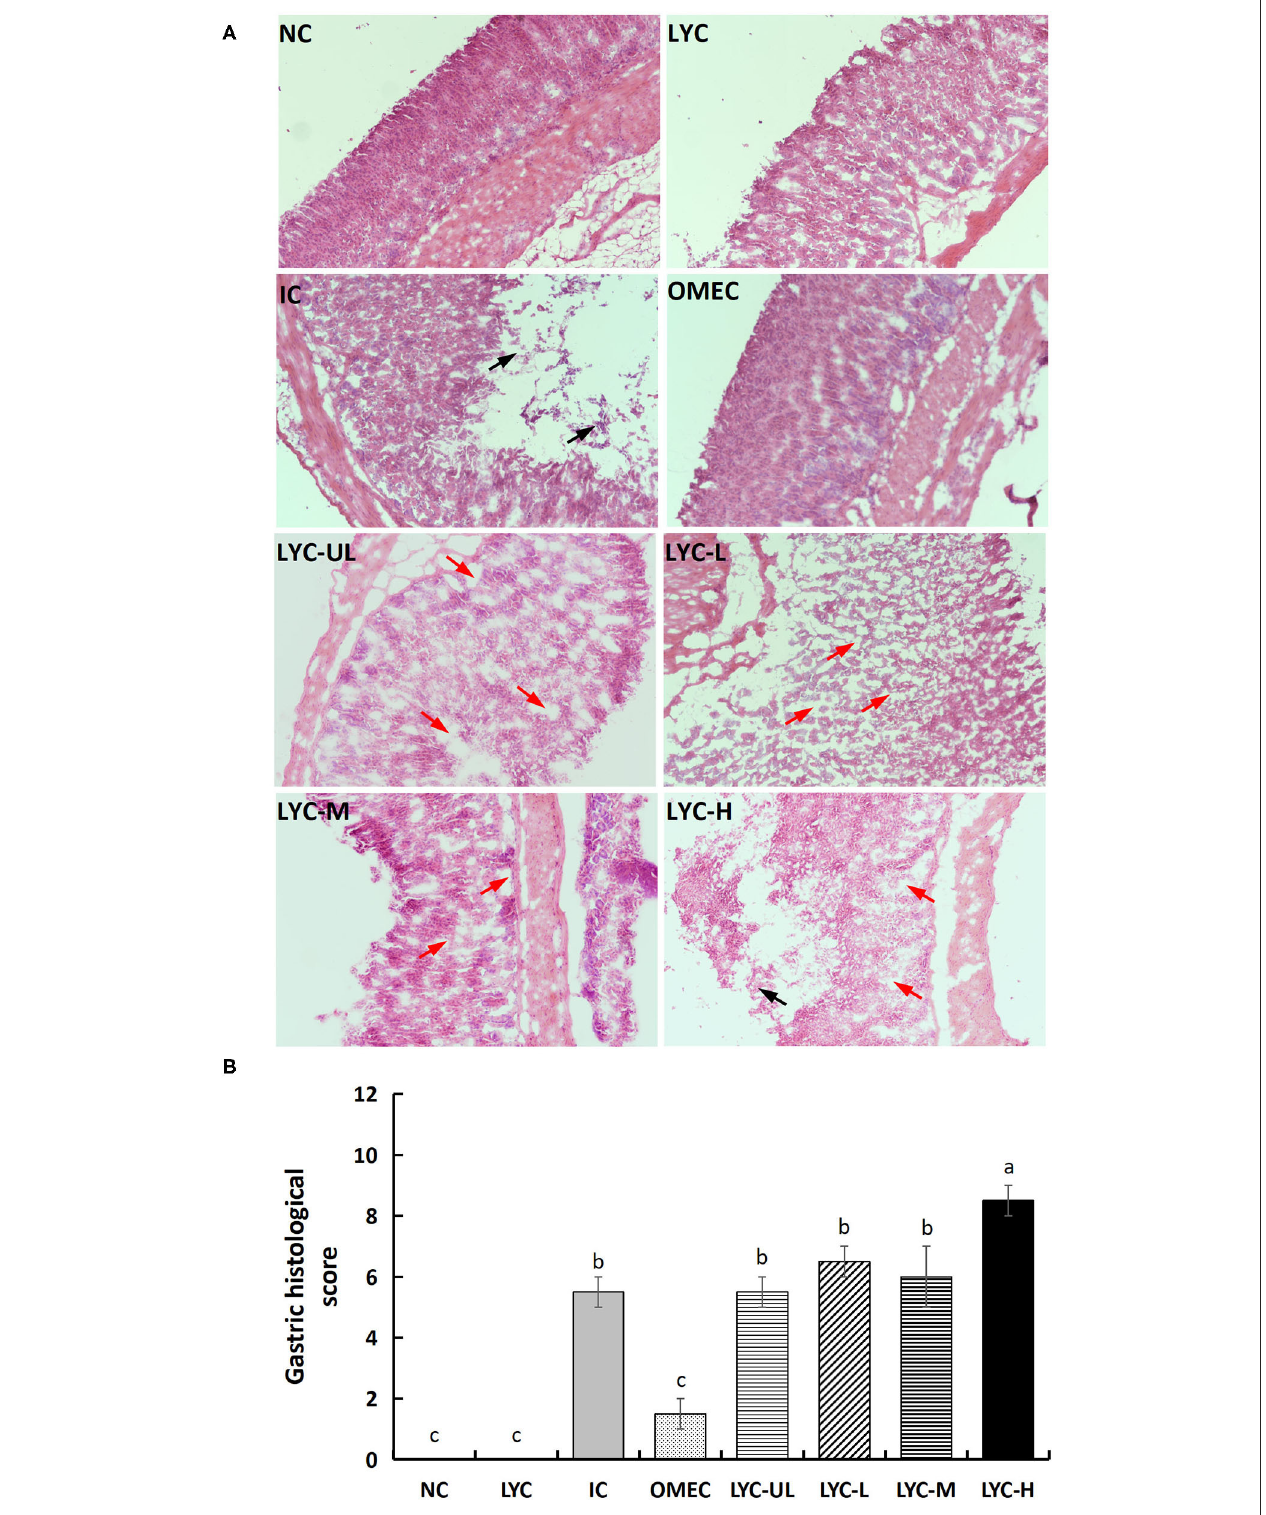
FIGURE 2 | Histological morphology (A) and total pathological scores (B) of gastric mucosa in mice (magnification 100 × ). NC, normal control; LYC, lycopene control group; IC, injury control group; OMEC, omeprazole control group; LYC-UL, ultralow-dose group; LYC-L, lycopene low-dose group; LYC-M, lycopene medium-dose group; LYC-H, lycopene high dose group. NC and LYC groups were perfused with distilled water; IC, OMEC, LYC-UL, LYC-L, LYC-M, and LYC-H groups were perfused with 6.67 ml/kg absolute ethanol. Different letters (a–c) indicate significant differences (P < 0.05) between different groups.